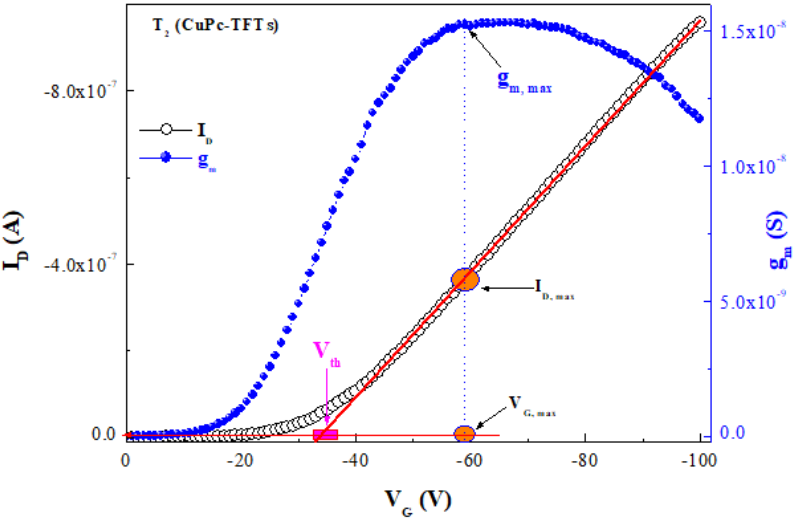
Figure 4. Illustration of the process of extraction of the V th by the linear extrapolation method from transfer characteristics I D – V G (left axis) and transconductance g m (right axis) as a function of V G in the linear regime (an example of measurement for T 2 (CuPc ‐ TFTs)).